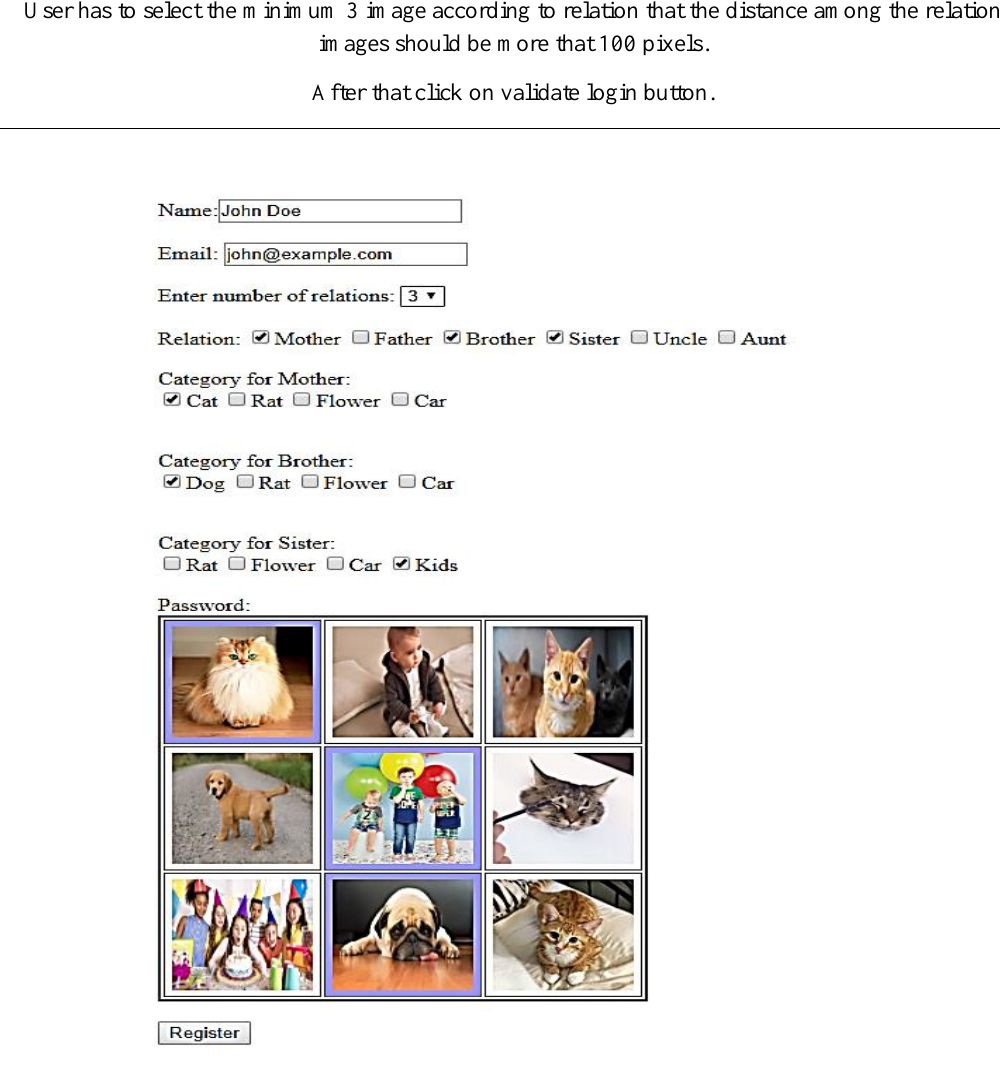
Figure 1. Process of